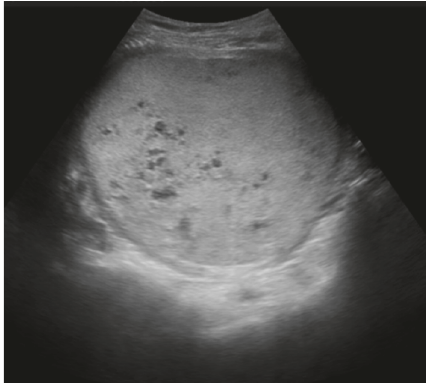
Figure 2: A pelvic ultrasound showing a large intrauterine het- erogeneous mass that includes multiple discrete anechoic spaces consistent with complete